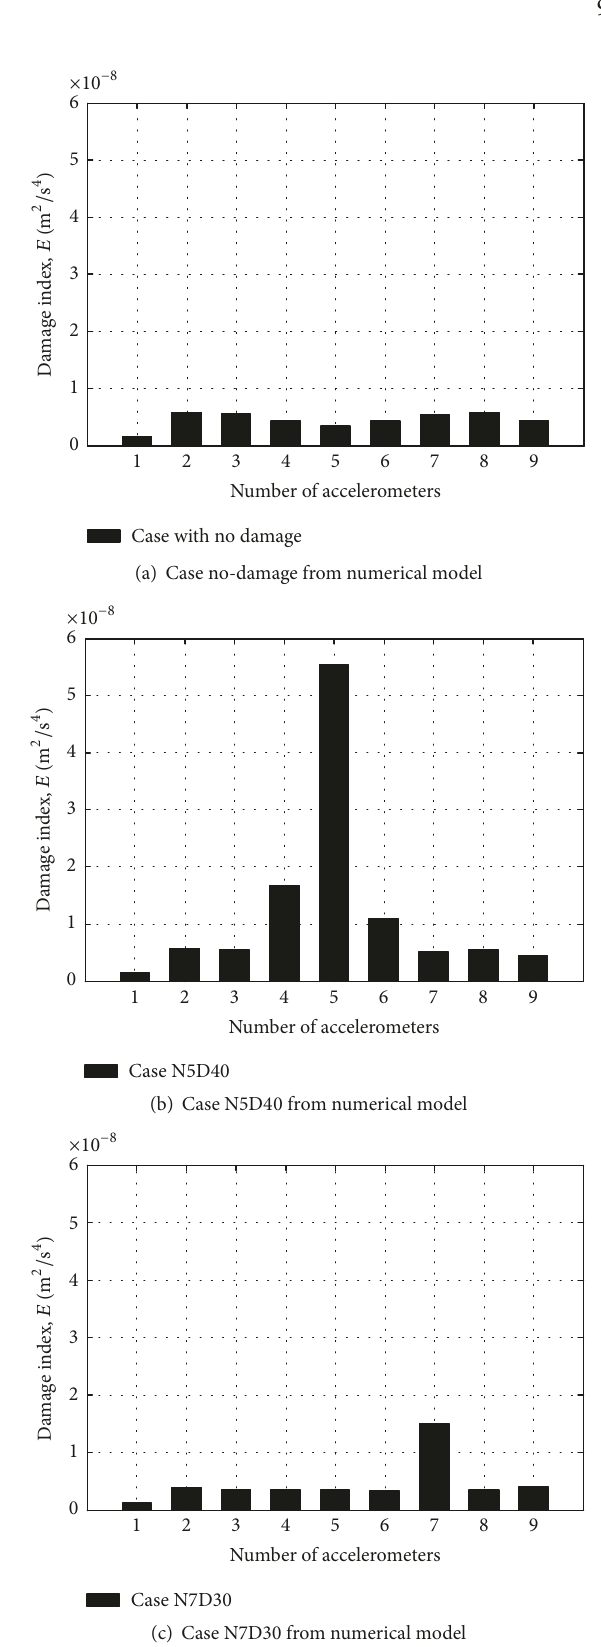
Figure 14: Distribution of damage index along the beams for differ- ent accelerometers (velocity = 0.3 m/s): (a) without any damage, (b) delta = 40 at Node 5, and (c) delta = 30 at Node